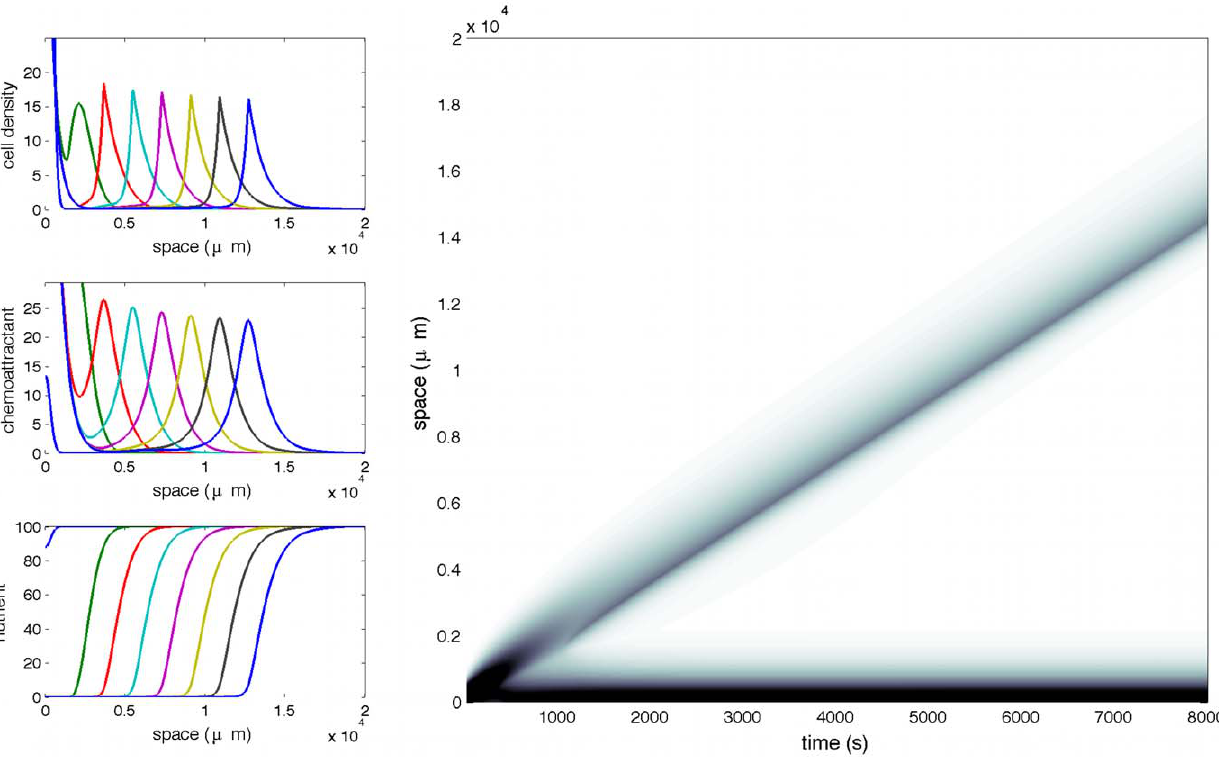
Figure 5. Coexistence of a stationary cluster and a traveling pulse. At low level of nutrient the cell population splits into two subpopulations. A fraction remains trapped at the boundary (as a stationary profile) and a fraction travels accross the channel with constant speed. Specific parameters are: d =10 2 1 and N 0 =10 2 .